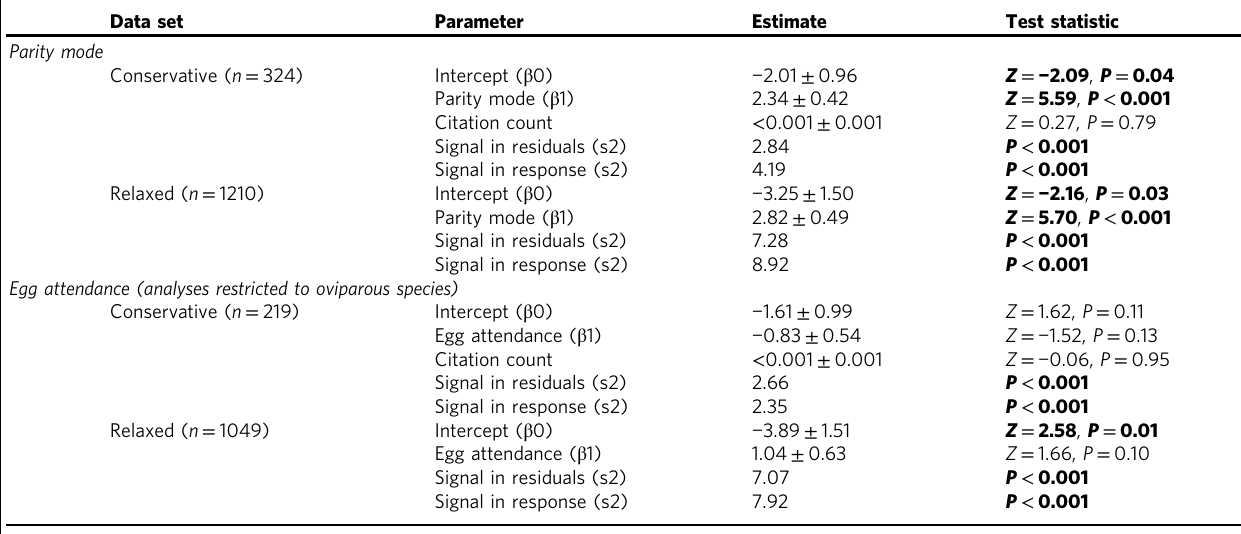
Table 1 Phylogenetic generalised linear mixed models (PGLMM) testing the in fl uence of parity mode and egg attendance on the occurrence of social grouping in squamate reptiles Data